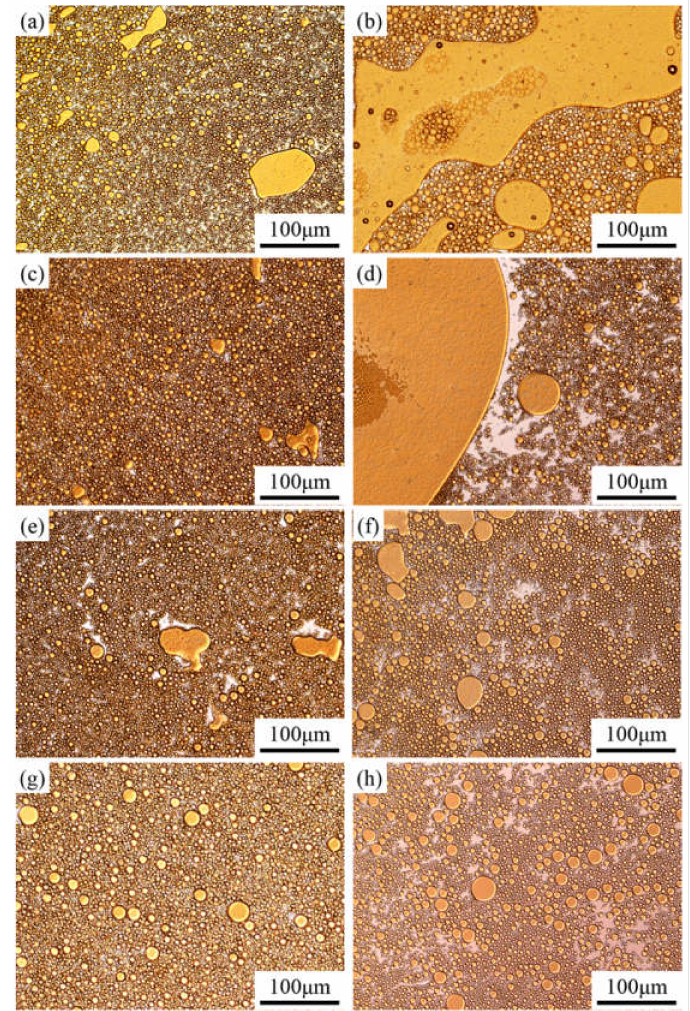
Figure 5. Optical micrographs of emulsions prepared from four kinds of PASBs with the same aqueous solution viscosity. Partial yellow is oil, and white is water. ( a ) Fresh, prepared from PASB-1; ( b ) 45 min later, prepared from PASB-1; ( c ) fresh, prepared from PASB-2; ( d ) 45 min later, prepared from PASB-2; ( e ) fresh, prepared from PASB-3; ( f ) 45 min later, prepared from PASB-3; ( g ) fresh, prepared from PASB-4; ( h ) 45 min later, prepared from PASB-4. According to Figure 6, the ∆ BS of the four emulsions at the bottom of the measuring cell decreased relatively significantly with time. The main reason for the decrease in light intensity here is the decrease in the oil phase volume fraction ( ϕ ) caused by the rise of oil droplets. After the droplets of larger particle size leave together from the bottom of the measuring cell, the remaining oil volume fraction is smaller than the upper part. This causes a sudden change in ∆ BS between the bottom and the top. As time increases, the minimum value of ∆ BS continues to decrease and moves to the left, which represents a phase separation at the bottom of the measuring cell. Such phase separation was measured when the emulsion stabilized by PASB-1 occurred in the measuring cell height range of 0 mm to 3 mm, while the emulsions stabilized by PASB-2, PASB-3, and PASB-4 occurred in the range of 0 mm to 2 mm. This means that the emulsion stabilized by PASB-1 is easier to phase-separate than the other three